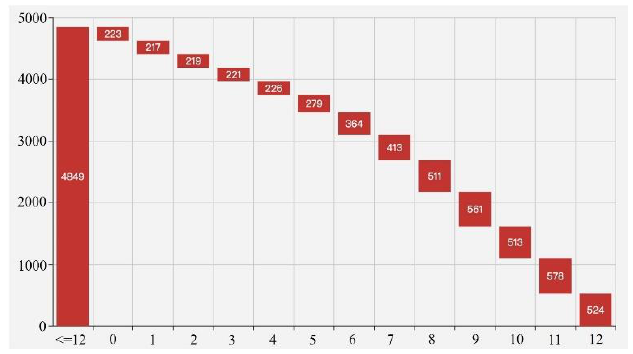
Figure 8. Information of the flag.